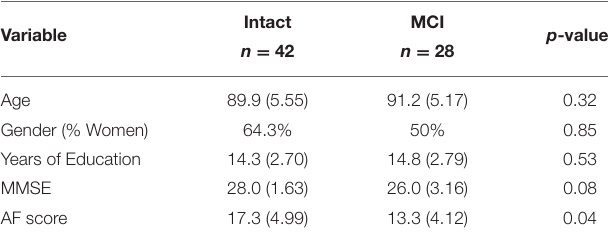
TABLE 1 | Baseline characteristics of MCI and demographically controlled